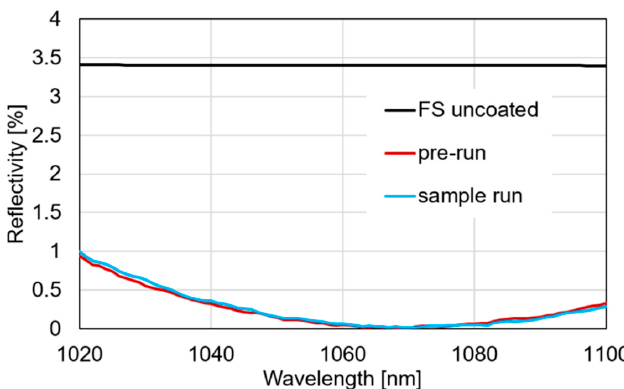
Figure 1. Measured reflectivity of the AR-coated fused silica test sample (AOI = 7°).